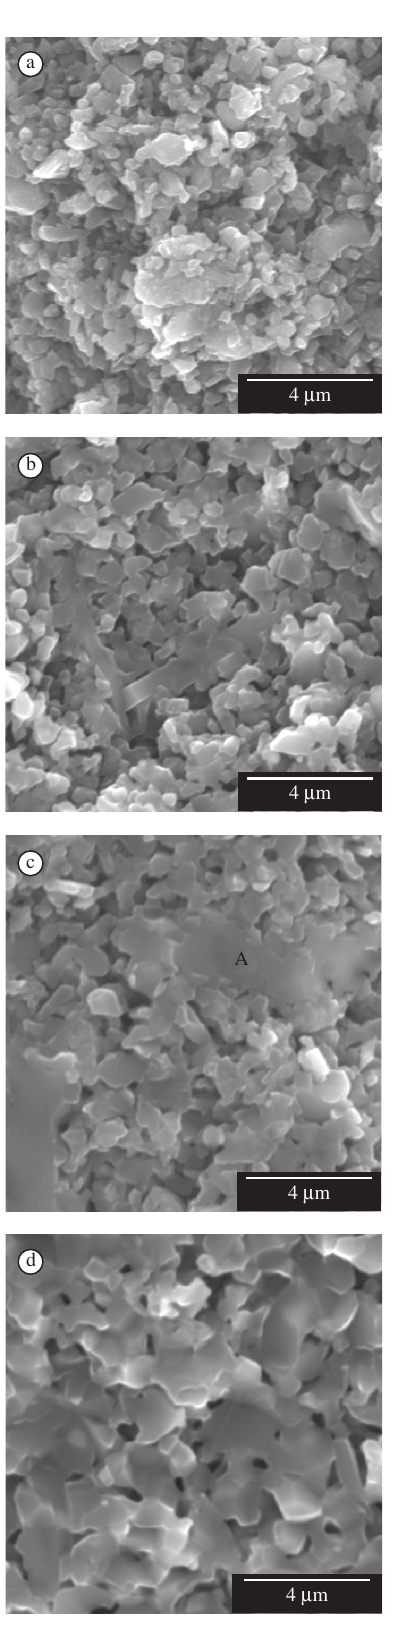
Figure 3. SEM images of: a) AlN-2% CaO sintered at 1600 °C for 7 minutes; b) AlN-2% CaO sintered at 1600 °C for 8 hours; c) AlN-2% CaCO 1700 °C for 1 hour; and d) AlN-2% Y letter A indicates a region with high Ca content determined by EDS analysis.